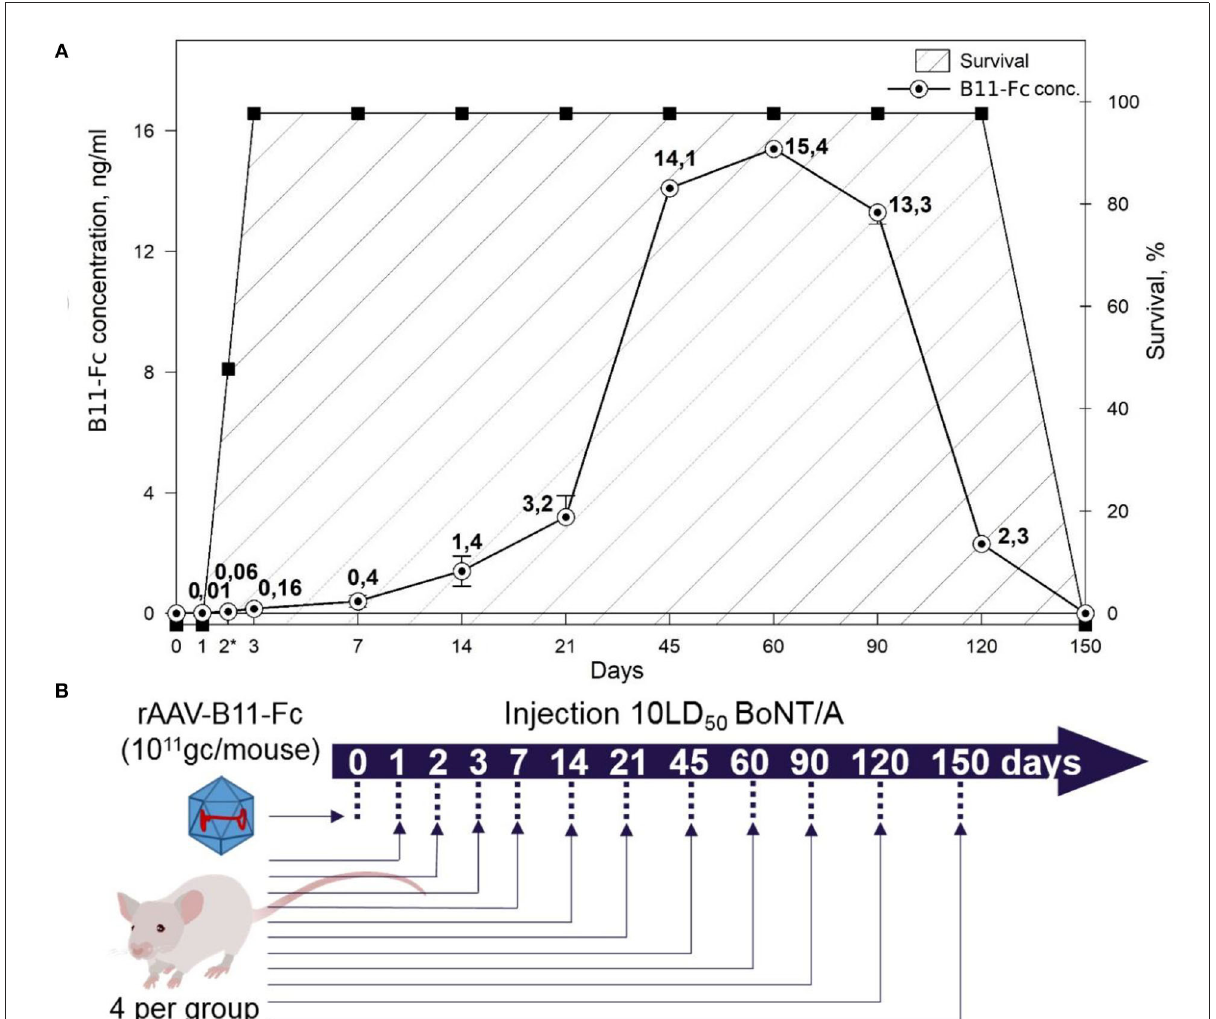
FIGURE4 (A) Correlation between the concentration of B11-Fc antibodies in the serum of treated mice at various time intervals after injection of the rAAV-B11-Fc at a dose of 10 11 gc/animal and survival of mice from 10LD50 BoNT/A. Symptoms of botulinum intoxication were monitored and marked with asterisks for partially surviving groups with mild abdominal symptoms. Survival – survival rate of mice. (B) Scheme of